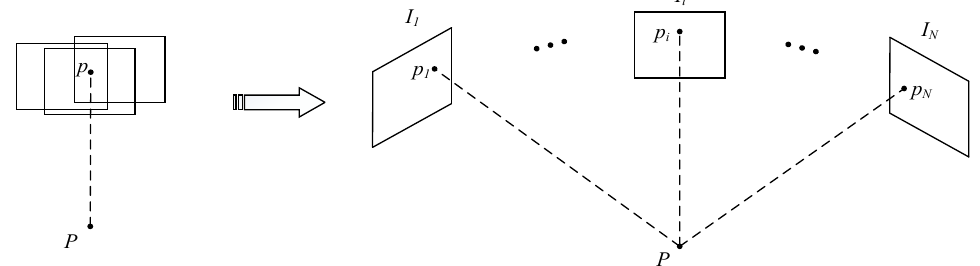
Figure 4. The 1- N mapping relationship between the TLS point cloud and digital images.